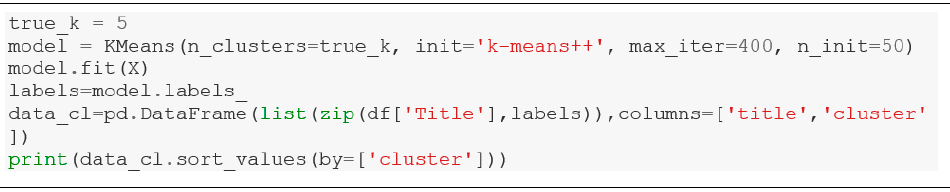
Figure 10. Elbow method for optimal k own elaboration,. 5. Results The results of this research correspond to the analysis of the informetric stage (stage 1) and the natural language processing (NLP) and machine learning (ML) stage (stage 2) and are presented below. No studies were found that integrated informetric analysis with other ML techniques to study scientific production in competencies in the field of BI&A and organizational leadership. 5.1. Results of Stage 1